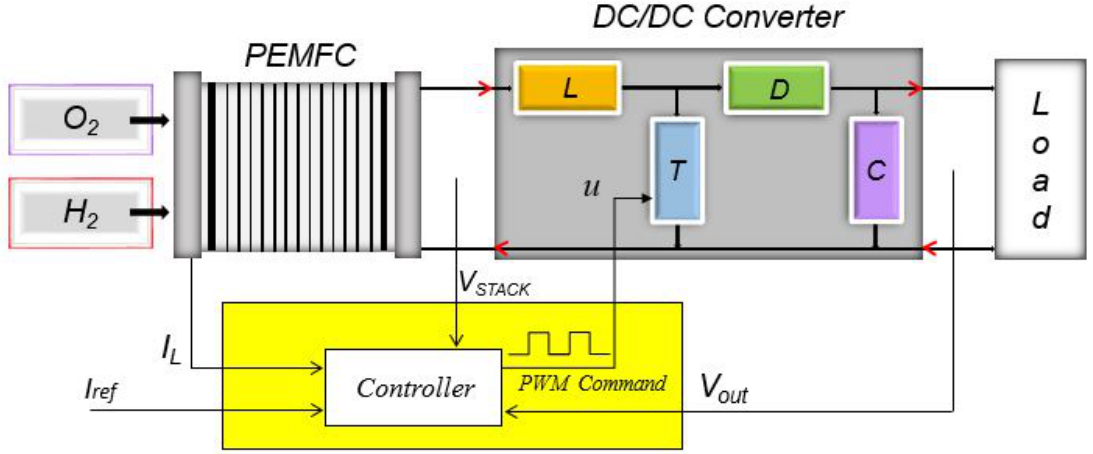
Figure 3. Synoptic diagram of the PEMFC control